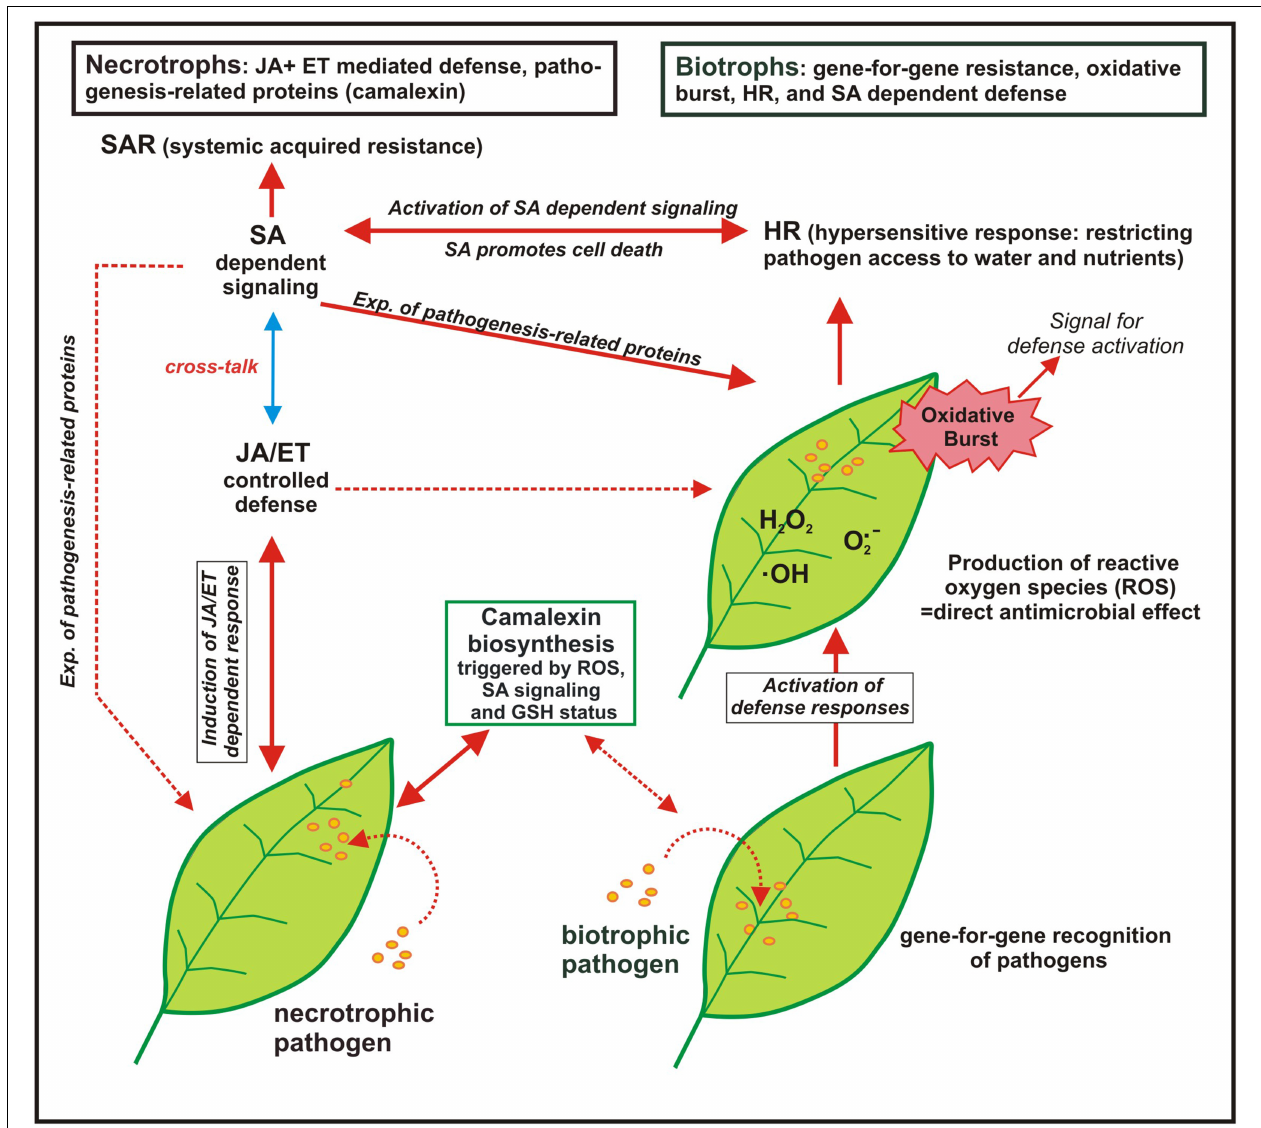
FIGURE 2 | Model of the response of plants to biotrophic and necrotrophic plant pathogens (adapted from Glazebrook (2005): displayed are the interactions of Arabidopsis with the biotrophs Peronospora parasitica and Erysiphe ssp. and with the necrotrophs Alternaria brassicicola and Botrytis cinerea ; SA, salicylic acid, JA, jasmonic acid, ET, ethylene; broken line arrows indicate to a possible interaction but which was not found in the chosen experiments while the solid line arrows indicate to the observed plant-pathogen-response). The defense reaction of Arabidopsis against biotrophic pathogens start with gene-for-gene recognition of the pathogen followed by rapid activation of defense and the production of reactive oxygen species (ROS), the so-called “oxidative burst,” which is by self